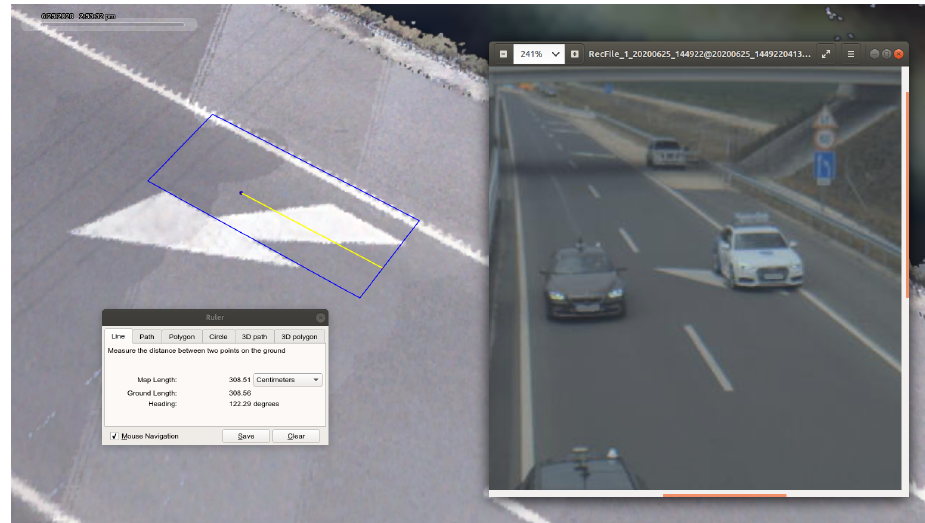
Figure 29. Outlines of white-blue Audi based on position data, plotted on UHD map of M86 section. The image was taken at the same moment. The position of the Audi on the image corresponds with the plotted outlines.